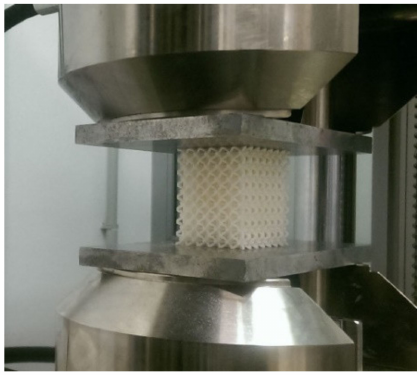
Figure 5. A view of a sample during the process of a compression